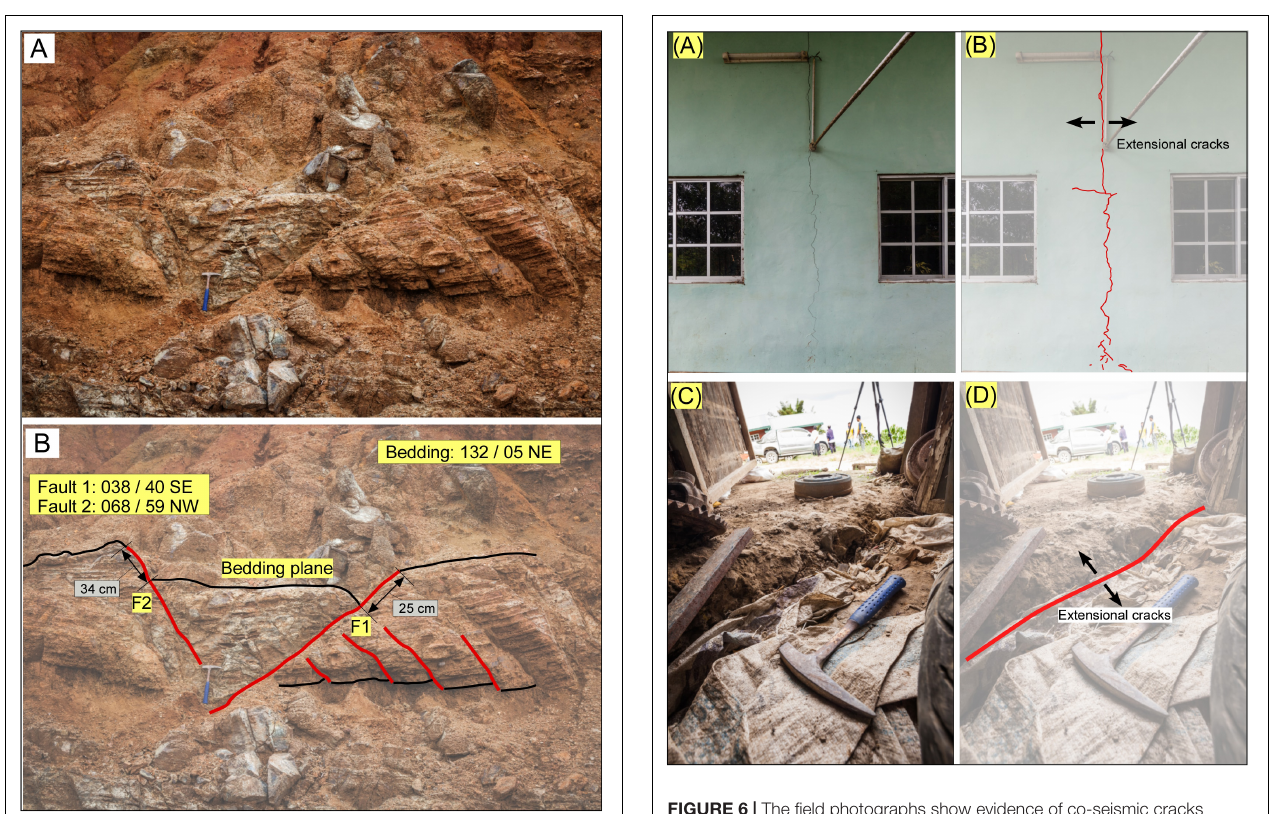
FIGURE 6 | The field photographs show evidence of co-seismic cracks that have developed during the June 2015 earthquake. The un-interpreted images are on the left (A,C) and interpreted images are on the right (B,D) of the